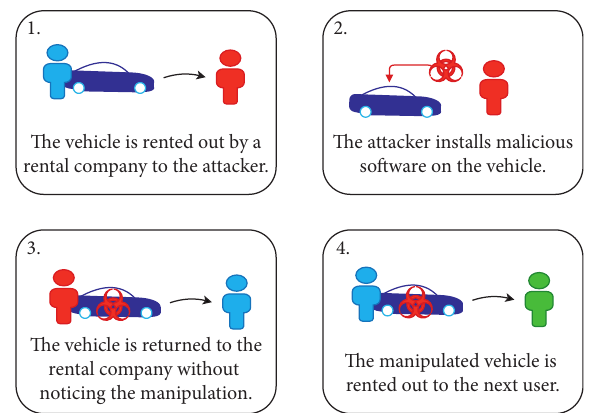
Figure 3: Possible attack scenario to manipulate a vehicle to harm an upcoming user of the